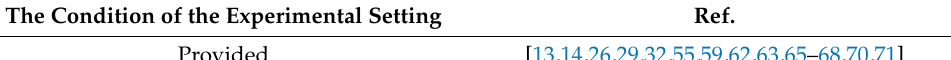
Figure 5. The distribution by the experimental setting. Table 5. The reference list of the distribution by the experimental setting.